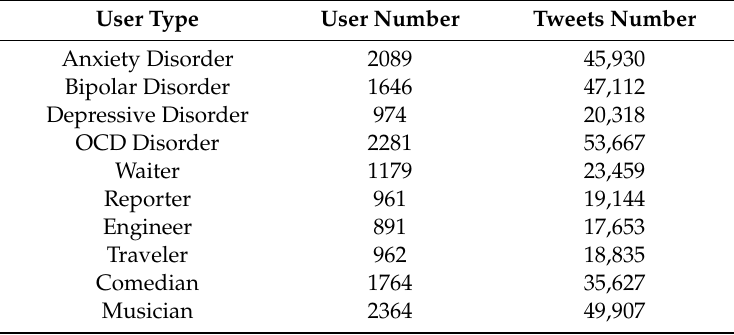
Table 6. Details of the Twitter dataset.